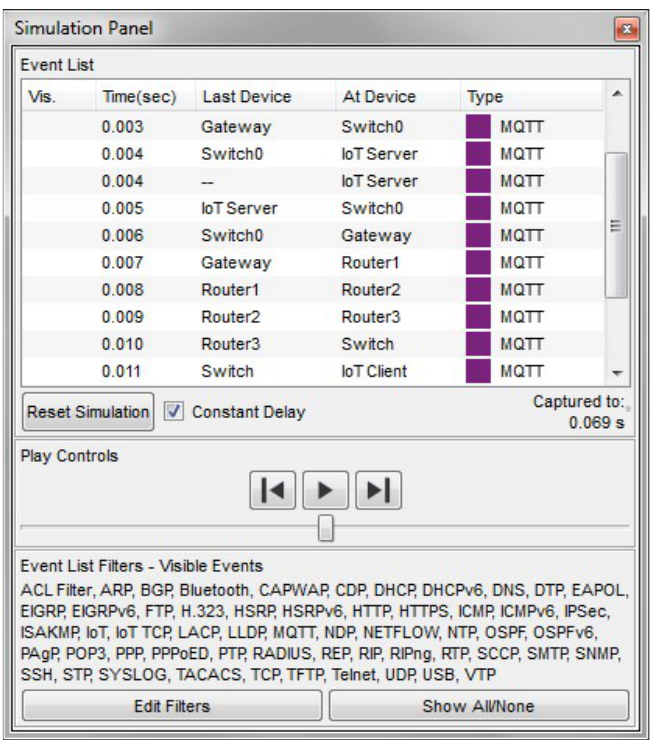
Figure 14. MQTT communication to subscribe a topic temperature.